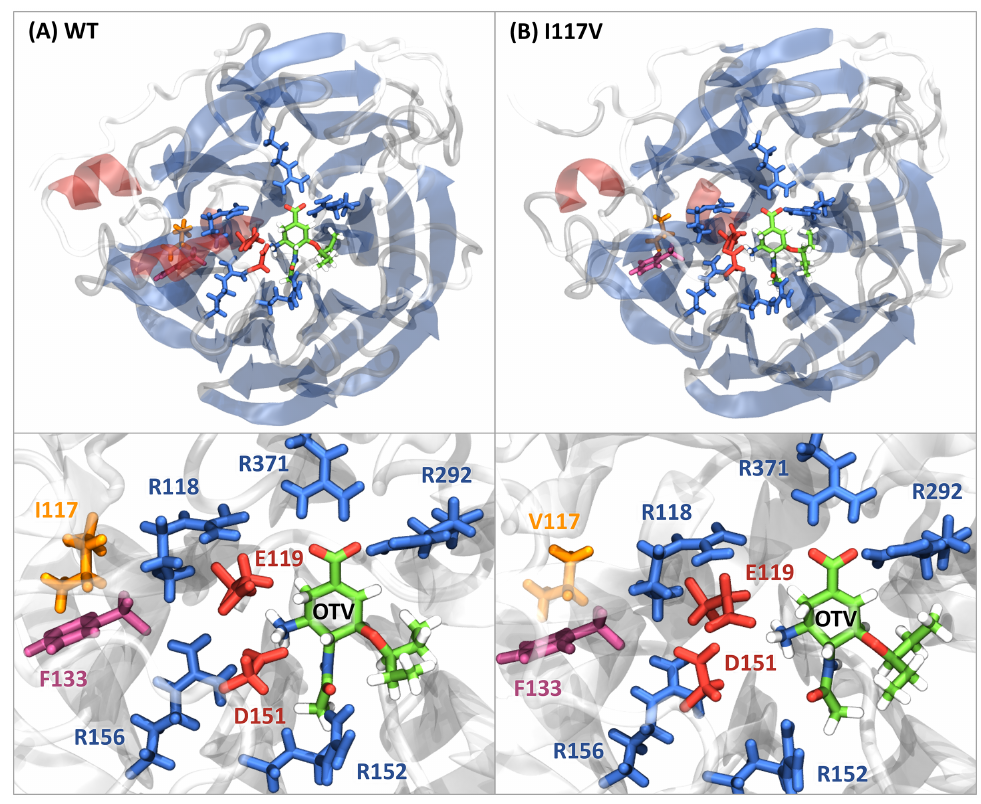
Figure 1 Snapshot images of the neuraminidase-oseltamivir complexes. (A) Wild-type (WT) and (B) I117V mutant NA-OTV complexes. The upper panels show the overall structure of the complex in the cartoon representation, where the helix and sheet parts are colored in red and blue, respectively. The lower panels show the drug-binding site and the region adjacent to residue 117, where the positively charged residues (R118, R152, R156, R292, and R371) in the OTV binding site are represented in blue, and the negatively charged residues (E119 and D151) are represented in red.